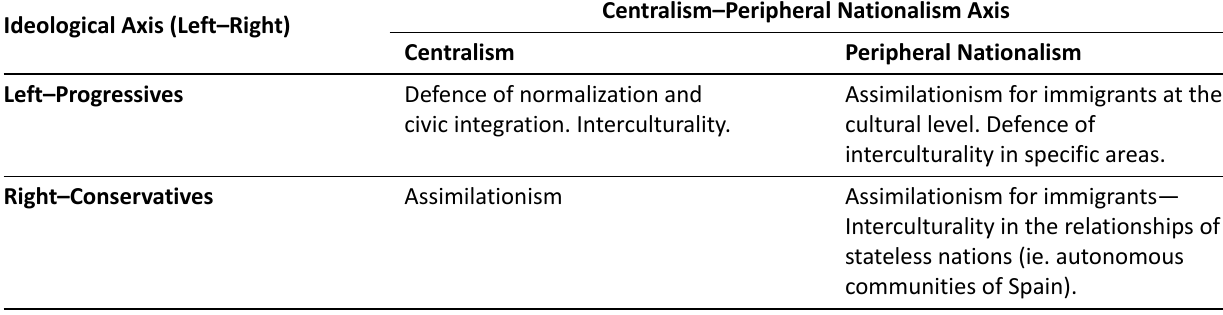
Table 2. Stances regarding political recognition of the identity of each migrant community (2008–2011). Source: Author’s compilation based on empirical data. Ideological Axis (Left–Right) Left–Progressives Defence of normalization and civic integration.